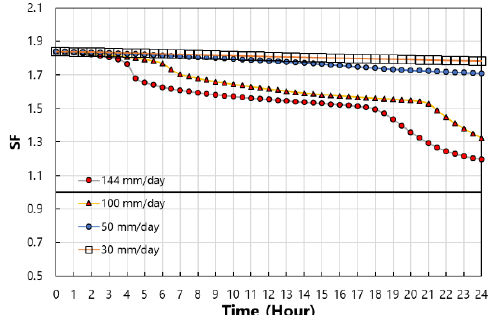
Figure 22. Change in safety factor with time under different flux for post-failure slope.